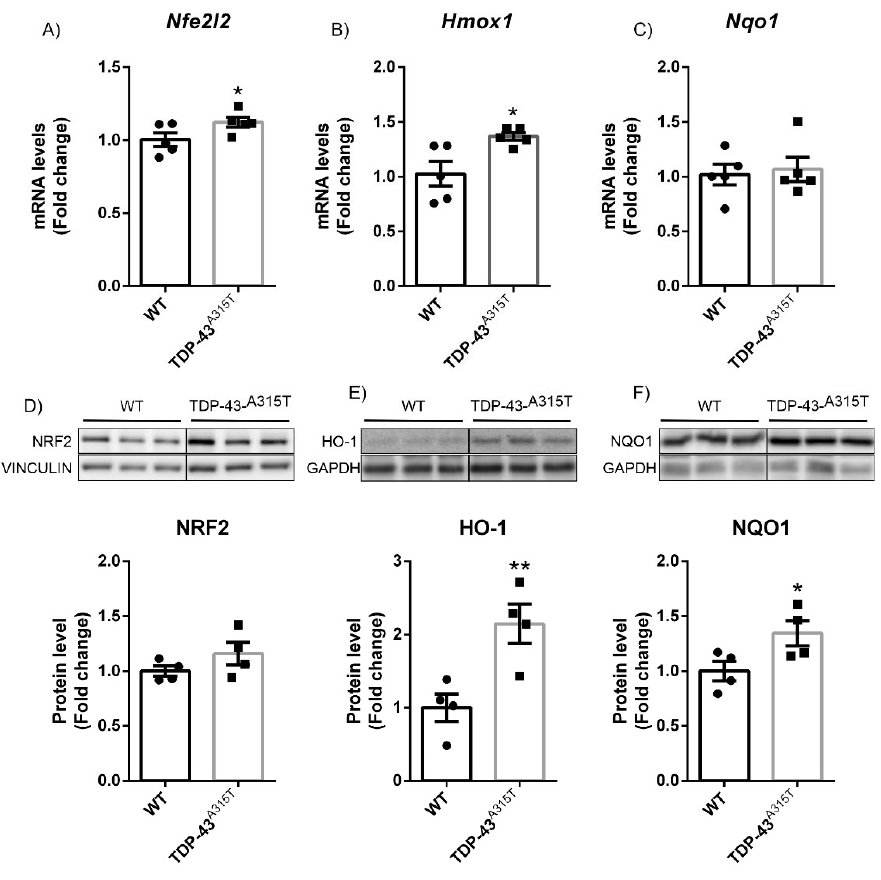
Figure 3. TDP-43 A315T transgenic mice showed increased HO-1 and NQO1 expression in lumbar spinal cord. Quantitative real-time PCR determination of mRNA levels of ( A ) Nfe2l2 , ( B ) Hmox1 , and ( C ) Nqo1 . All genes were normalized by Tbp (TATA box binding protein) mRNA levels; n = 4–5 samples ± SEM. Asterisks denote significant differences at * p < 0.05 and ** p < 0.01 when comparing the indicated group to the wild-type mice according to the Student’s t -test. Protein levels of ( D ) NRF2, ( E ) HO-1, and ( F ) NQO1 were analyzed by immunoblotting and their respective protein quantifications; n = 4 samples per experimental group ± SEM. Asterisks show significant differences at * p < 0.05 when comparing groups according to the Student’s t ‐ test.